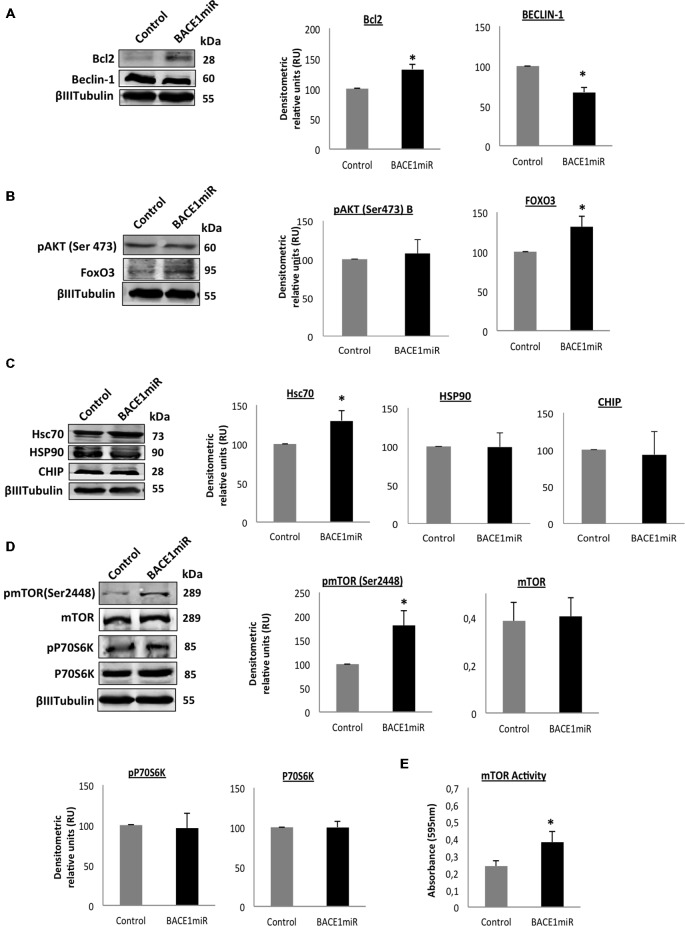
Silencing of BACE1 upregulates the survival signaling in 3xTg-AD mice. Survival and quality control regulation pathways were analyzed. (A) Bcl2/Beclin-1, (B) Akt/FoxO3, (C) Hsc70/Hsp90/CHIP protein levels, (D) mTOR pathway and its activity (E) from the hippocampi of 3xTg-AD mice 24-month-old after 6 months of injection with AAV2/5-BACE1miR and AAV2/5-GFP version as control. Representative blots are shown. RU = relative unit. n = 4, *p < 0.05.